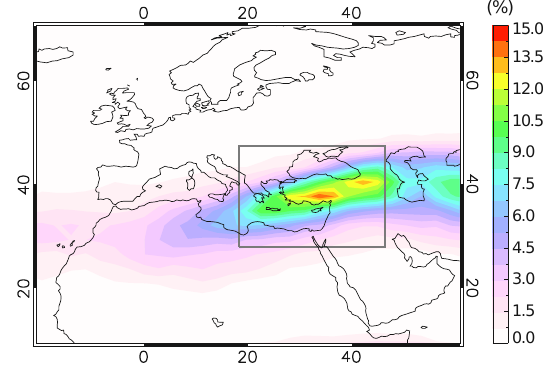
Figure 2. Mean tropopause fold frequencies (%) during summer for the period 1979–2013 from EMAC simulations. The box indicates the domain of interest (see Sect.